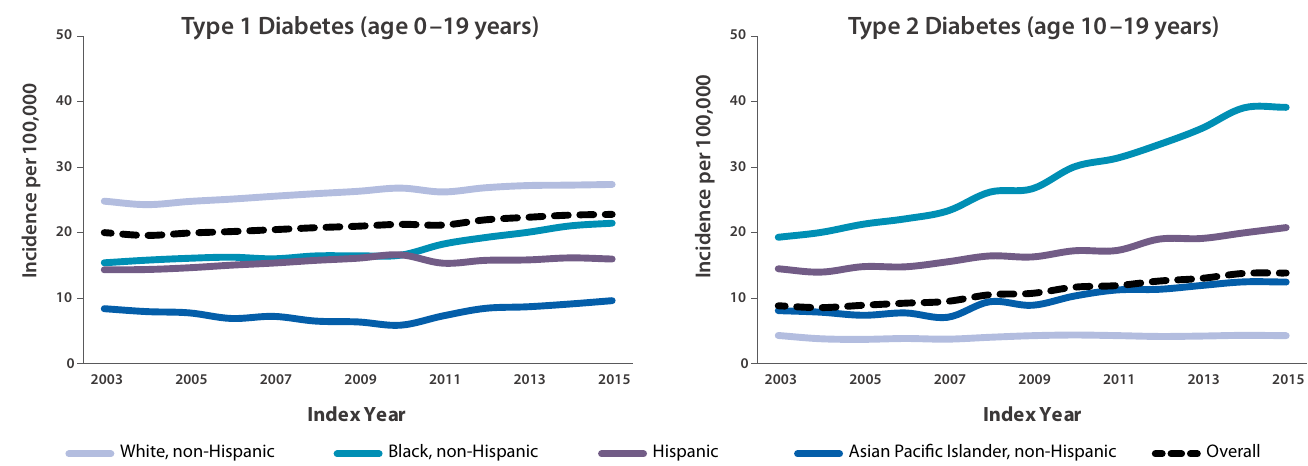
White, non-Hispanic Black, non-Hispanic Hispanic Asian Pacific Islander, non-Hispanic